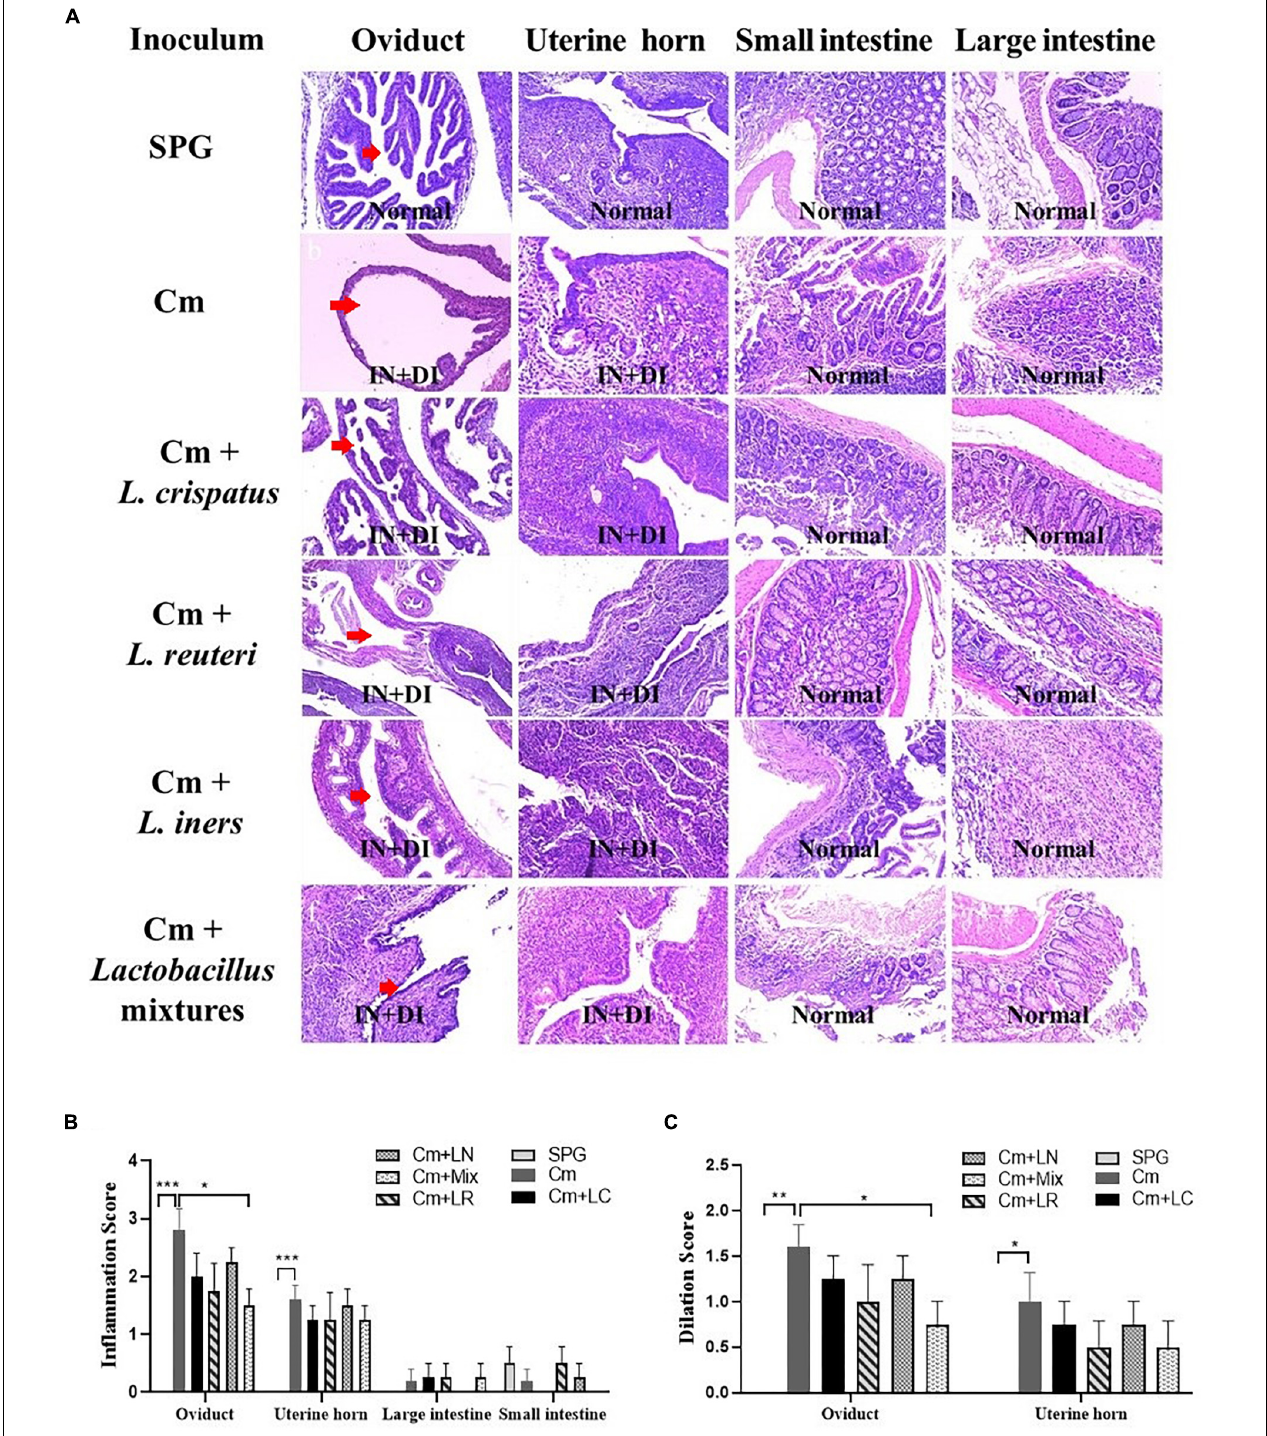
FIGURE 6 | Effects of lactobacillus intravaginal administration on chlamydia-induced mouse genital and intestinal tract pathologies, following intravaginal infection with C. muridarum . (A) The groups of the mice were treated as described in the Figure 3 legend. The urogenital tract tissues were subjected to histological section analyses for observing inflammatory pathologies via H&E staining. Sections of oviduct and uterine horn tissues from the mice in each group were examined for both inflammatory infiltration (IN) and lumenal dilatation (DI) (red arrows), whereas small and large intestine tissues for inflammatory infiltration. The extent of inflammation (B) and dilatation (C) was semiquantitatively scored as described in the method section. The scores were calculated as the means and standard deviations for each group. * p < 0.05, ** p < 0.01, and *** p < 0.001 vs. the Cm group (one-way ANOVA).